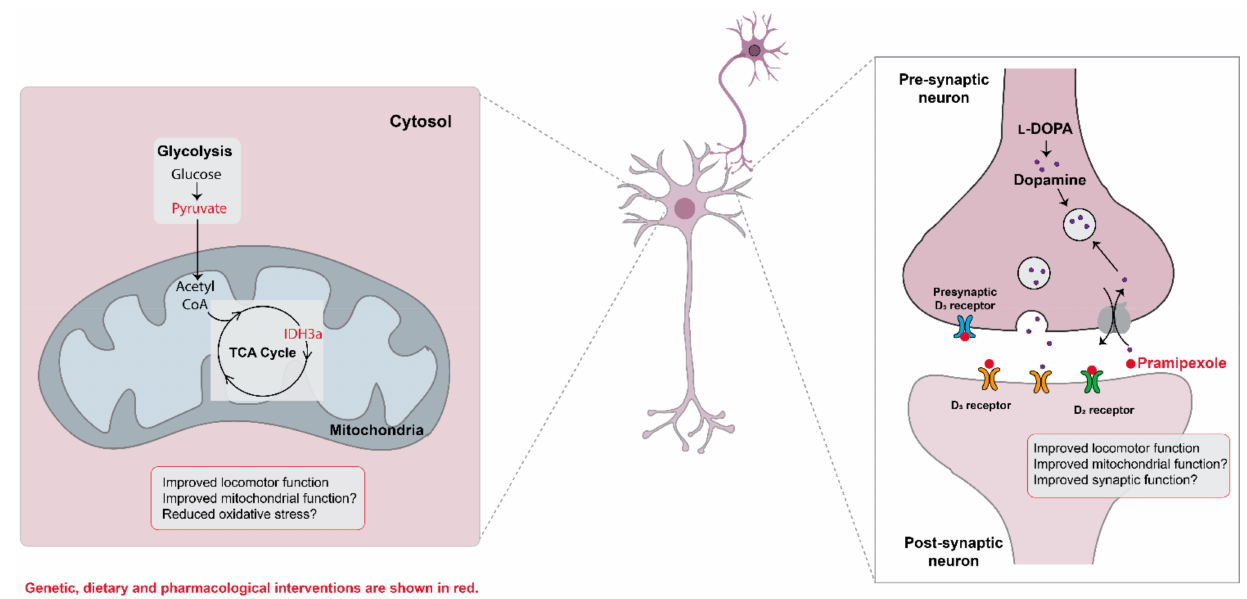
Figure 5. Proposed model depicting metabolic pathways altered in TDP-43 proteinopathy. Among several metabolic changes, the TCA cycle is upregulated, likely as a compensatory mechanism. Pyruvate treatment or IDH3a overexpression improves locomotor function, either by improving mitochondrial function and/or by mitigating oxidative stress. Additionally, neurotransmitter systems are altered, including dopamine. Pramipexole, a dopamine agonist, mitigates TDP-43 induced locomotor deficits, either by improving mitochondrial and/or synaptic function. Dietary, genetic, or pharmacological interventions are shown in